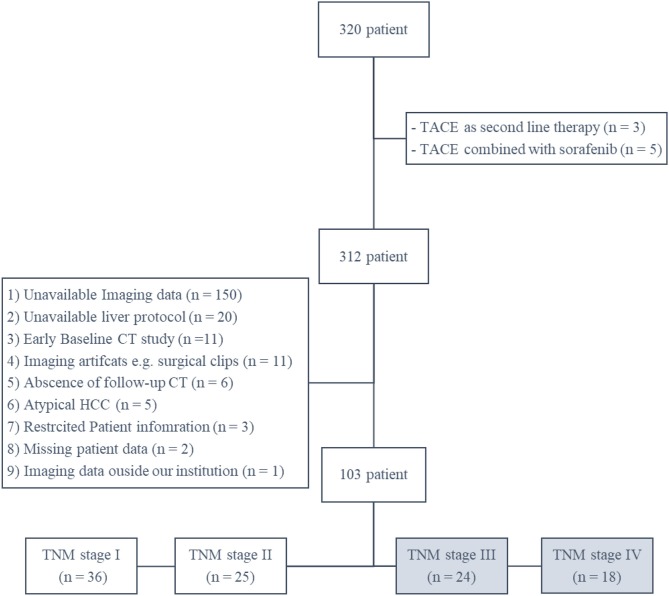
A schematic Flowchart of patient cohort selection process including the exclusion criteria.